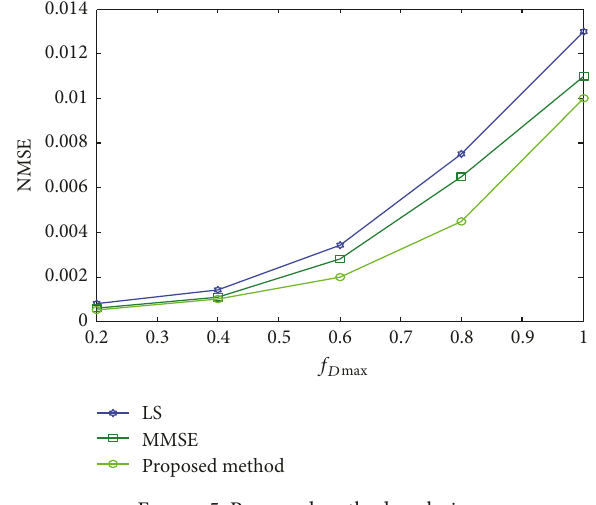
Figure 5: Proposed method analysis.